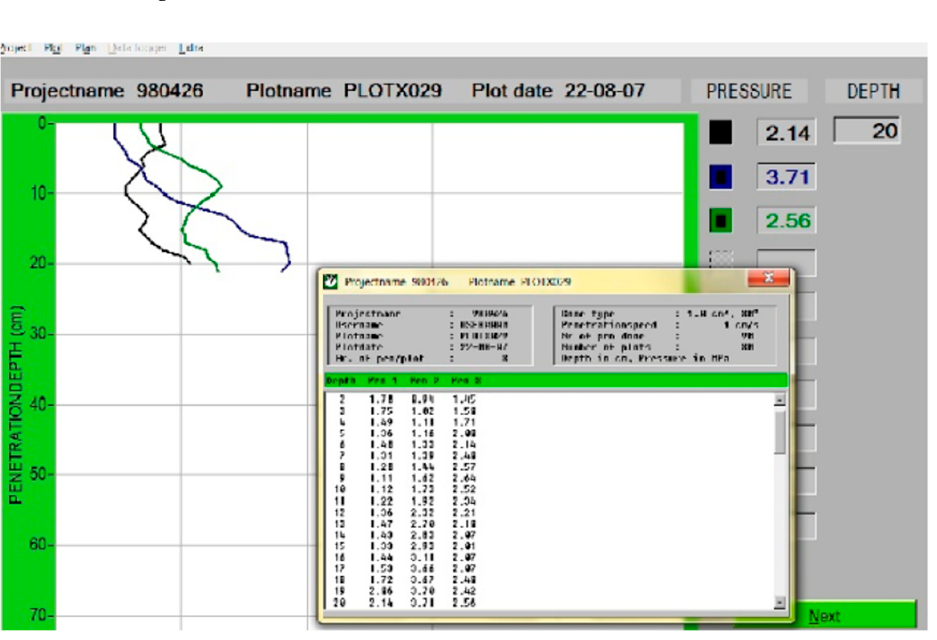
Figure 1. An example of soil cone penetrometer data (MPa) at depths up to 20 cm.